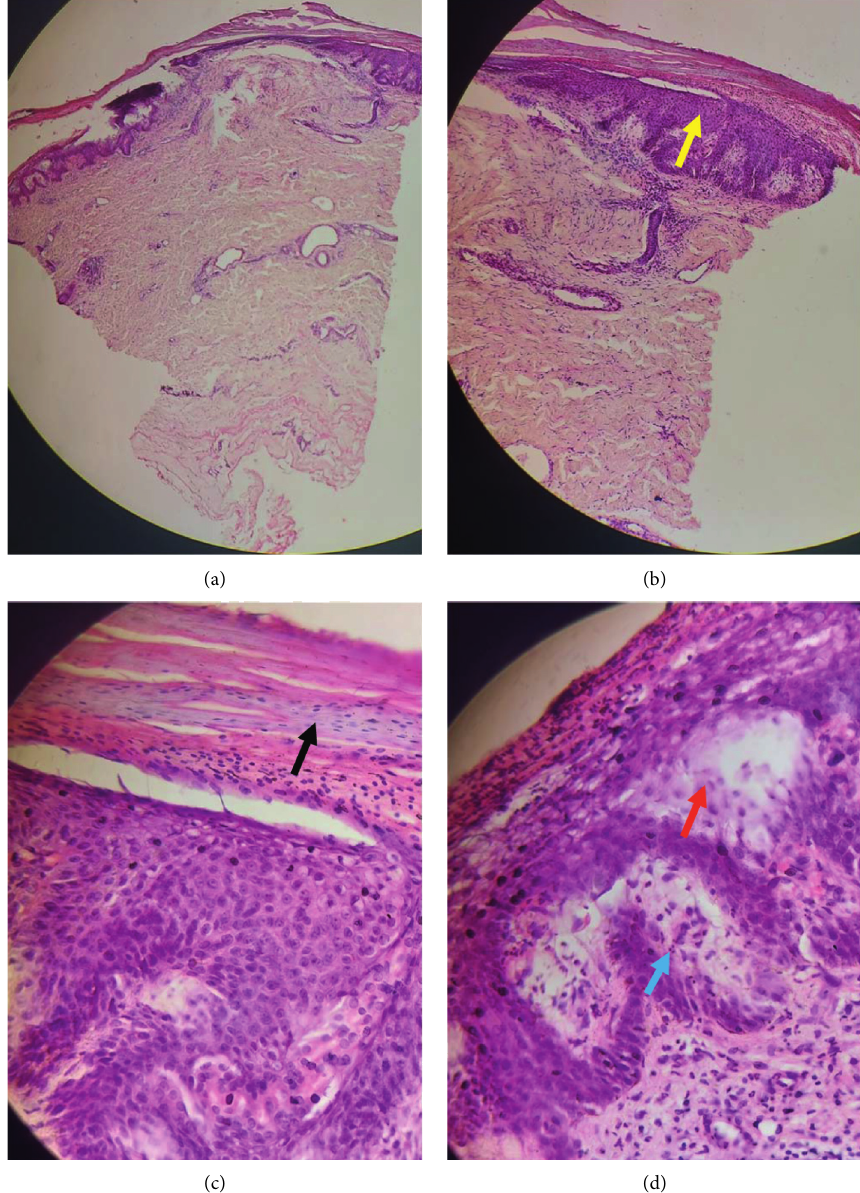
Figure 2: Hematoxylin-and-eosin-stained skin biopsy showing (a) the epidermis and dermis; (b) acanthosis (yellow arrow); (c) parakeratosis (black arrow); and (d) neutrophilic epithelial infiltrate (blue arrow) and spongiosis (red arrow). (a) × 100, (b) × 200, and (c) and (d) × 400